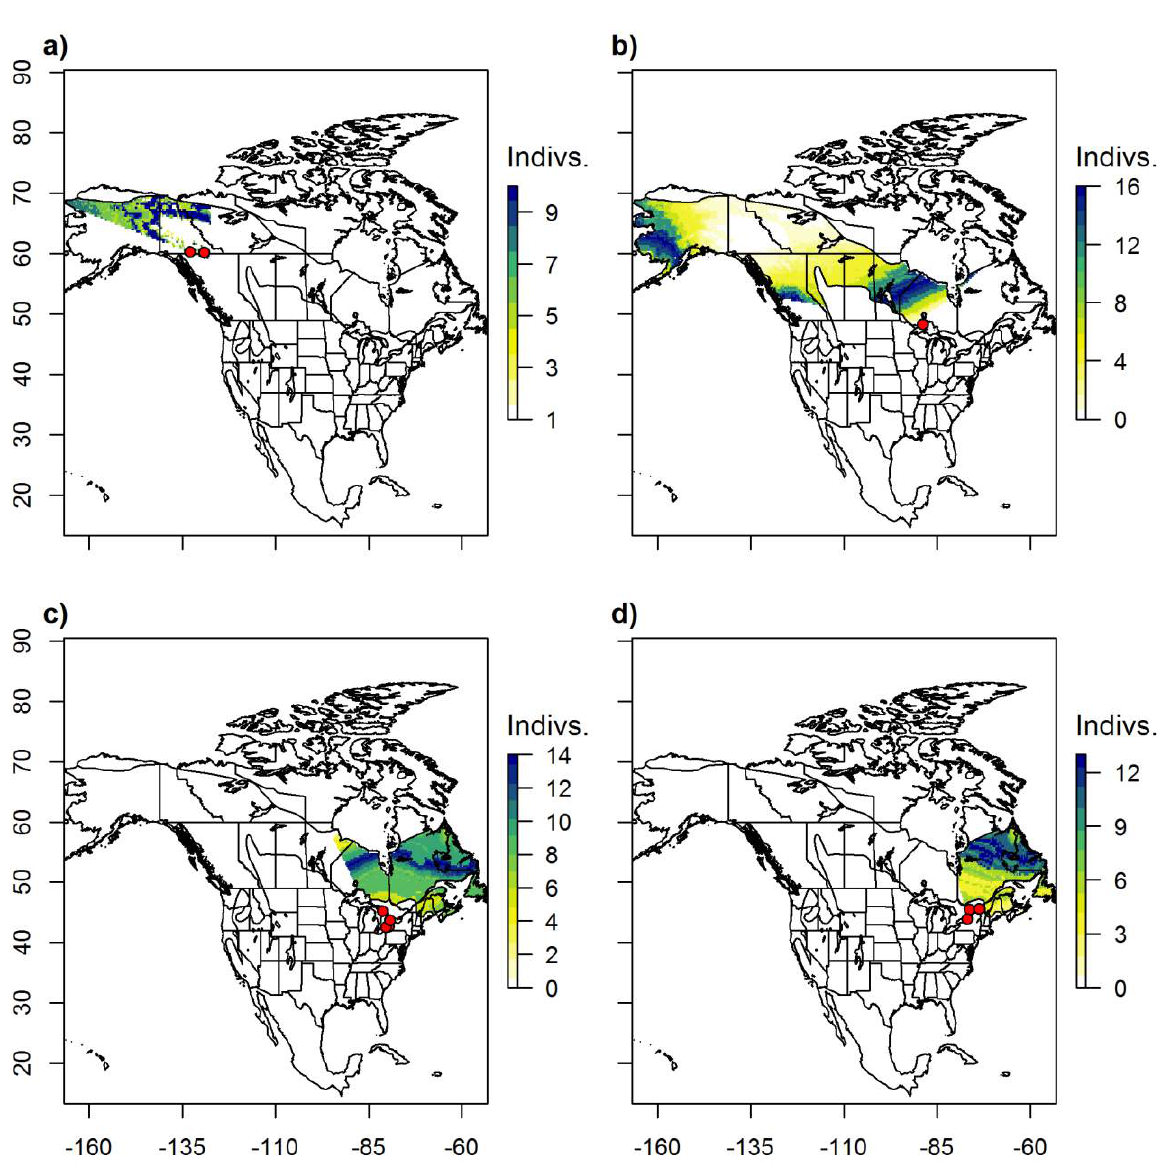
Figure A2.21: Probable origins of Wilson’s Warblers ( Cardellina pusilla ) captured during spring migration at CMMN stations in a) the Yukon (ACBO (n=15), TLBBS (n=10)); b) Western Ontario (TCBO (n=21)); c) Southwest Ontario (AuBO (n=4), BPBO (n=4), HBO (n=6), LPBO (n=3), PIBO (n=4), TTPBRS (n=4)); and d) Southeast Ontario & Southwest Québec (IPBO (n=6), MBO (n=5), PEPTBO